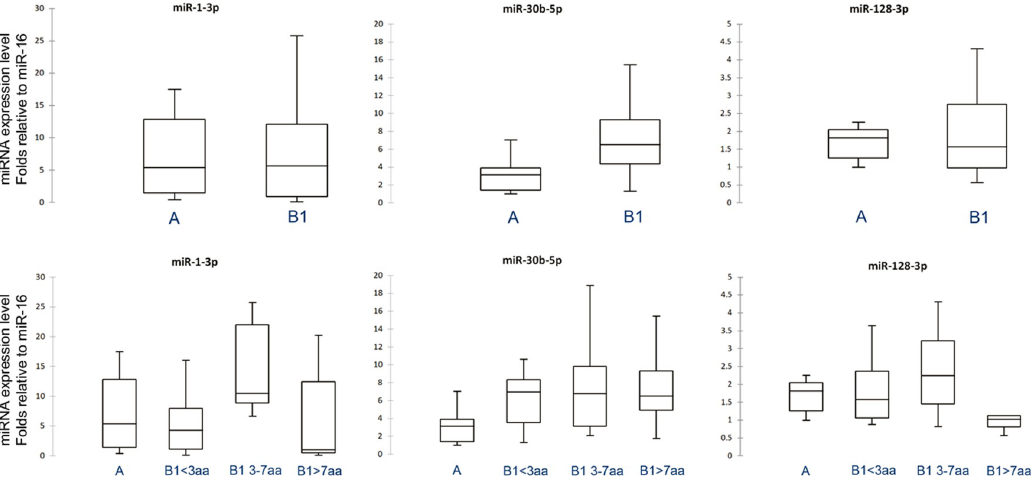
Fig 1. Expression levels of miR-1-3p, miR-30b-5p, and miR-128-3p between groups. Expression levels of the three miRNAs between groups A and B1 (A-C, respectively) and between A and B1 were divided according to the age at MMVD diagnosis (D-F, respectively). MiR-30b-5p increased 2.4 folds ( P < 0.05) in group B1 compared to A (B). Splitting group B1 according to the age of dogs, the expression of miR-30b-5p remained significantly higher (E). Group B1 < 3 (2.3 folds, P = 0.034), B1 3–7 (2.2 folds, P = 0.028), and B1 > 7 (2.7 folds, P = 0.018) expressed a higher level of miR-30b-5p than group A. No differences were found in the amount of miR-1-3p (A and D) and miR-128-3p (C and